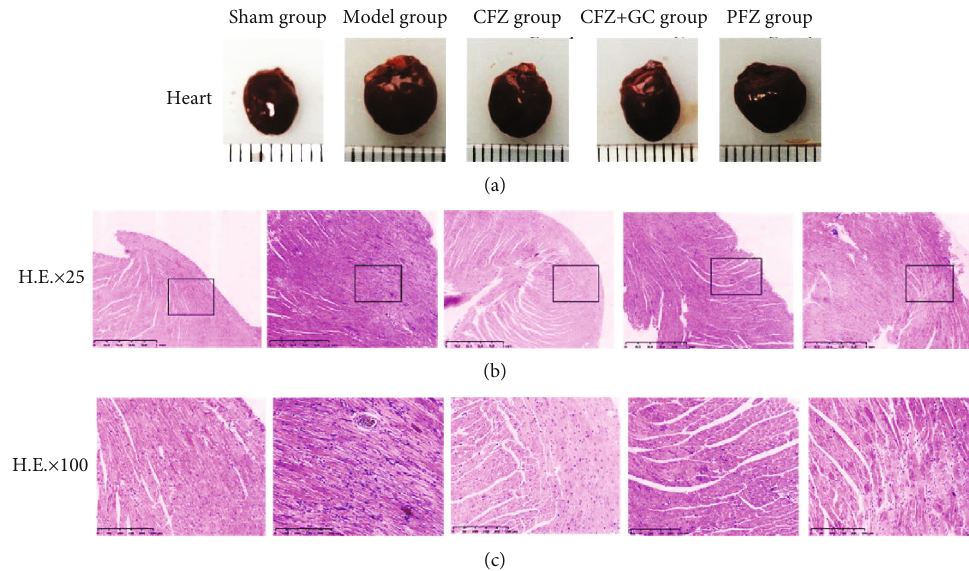
Figure 5: Heart morphologies and myocardial hematoxylin and eosin (HE) staining in each group. (a) Representative images of the heart. (b) Representative images for the pathological changes of the heart, scalebar = 1mm . (c) Representative images for the pathological changes of the heart, scale bar = 250 μ m .